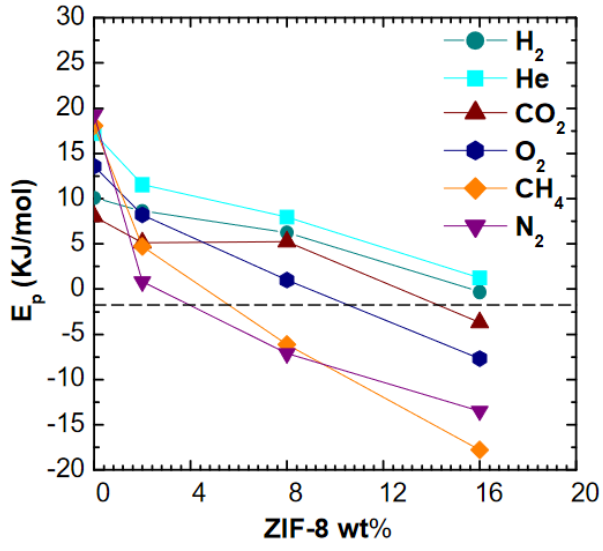
Figure 8. Activation energy of permeation of various gases in PSf/ZIF-8 mixed matrix membranes as a function of ZIF-8 wt%.